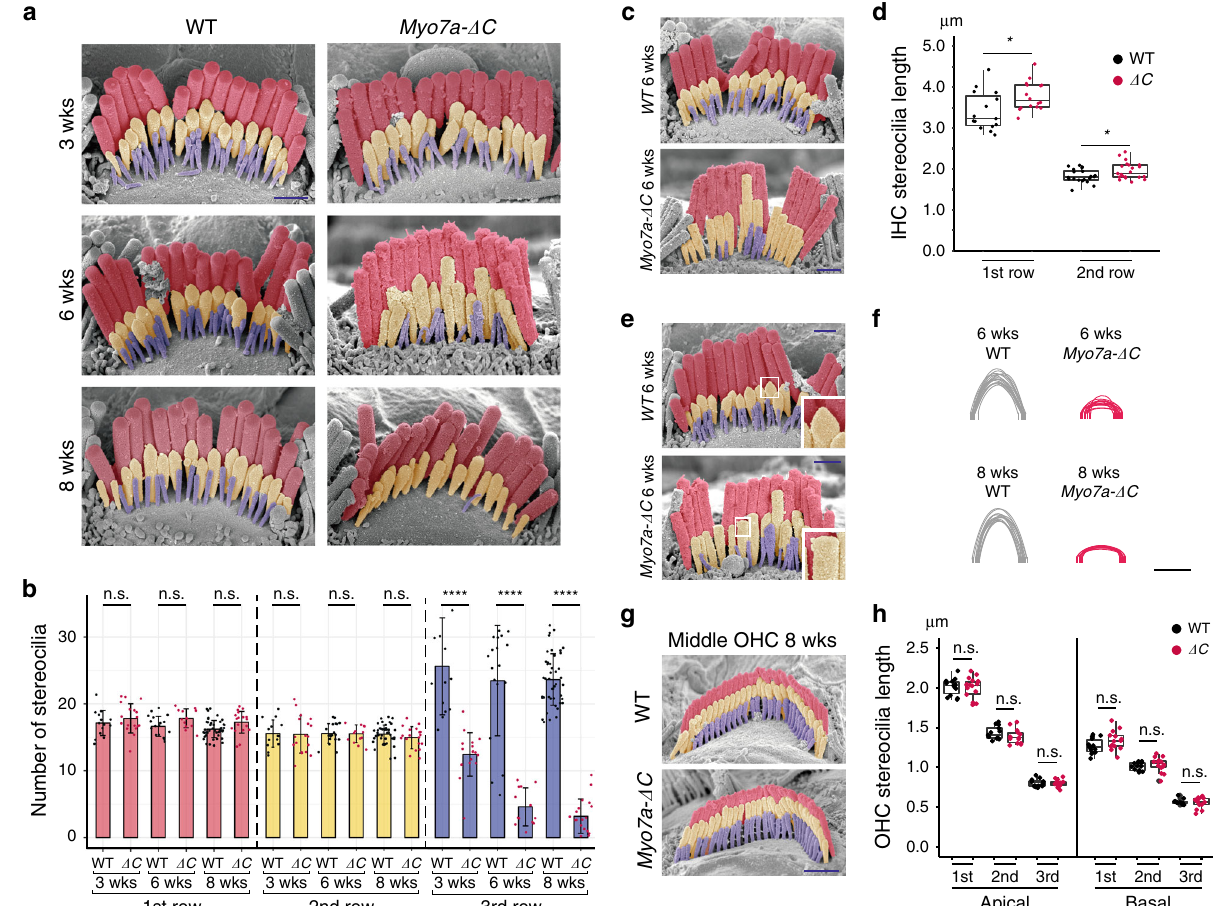
Fig. 8 IHC stereocilia degenerate in Myo7a- Δ C mice. a , b SEM analysis at 3, 6, and 8 weeks. The fi rst, second, and third row of stereocilia are shown in red, yellow, and blue, respectively. Number of third row stereocilia in Myo7a- Δ C IHCs decreases progressively: mean third row stereocilia number ± SD per cell (number of cells; animals): 3 weeks WT = 25.64 ± 7.25 (14;3), Myo7a- Δ C = 12.44 ± 3.26 (18;3), p = 7.28e − 23. 6 weeks WT = 22.65 ± 2.79 (36;6), Myo7a- Δ C = 4.50 ± 3.03 (20;5), p = 7.28e − 23. 8 weeks WT = 20.83 ± 4.54 (35;3), Myo7a- Δ C = 3.84 ± 2.54 (31;3), p = 9.41e − 26. c , d First and second row stereocilia of Myo7a- Δ C IHCs are longer than WT counterparts. SEM images are collected from the middle turn. Mean stereocilia lengths at 6 weeks (averaged by cell) ± SD. First row: WT = 3.41 ± 0.47, Myo7a- Δ C = 3.78 ± 0.35, p = 0.021; analyzed numbers (stereocilia; cells; animals) for WT (95;15;5) and Myo7a- Δ C (86;16;5). Second row: WT = 1.83 ± 0.17, Myo7a- Δ C = 1.96 ± 0.21, p = 0.033. Analyzed numbers (stereocilia; cells; animals) for WT (116;20;3) and Myo7a- Δ C (159;21;3). e , f Loss of prolate tips in second row stereocilia in Myo7a- Δ C IHC. Stereocilia tips were traced and superimposed. g , h OHC bundles at 8 weeks were not affected in Myo7a- Δ C mice. SEM-based quanti fi cation of stereocilia lengths: basal OHCs: First row: WT = 1.27 ± 0.094, Myo7a- Δ C = 1.34 ± 0.12, p = 0.089. Second row: WT = 1.01 ± 0.050, Myo7a- Δ C = 1.032 ± 0.096, p = 0.52. Third row: WT = 0.57 ± 0.031, Myo7a- Δ C = 0.55 ± 0.069, p = 0.58. Analyzed numbers (stereocilia; cells; animals) for WT (188;14;5) and for Myo7a- Δ C (153;12;4). Apical OHCs: First row: WT = 2.01 ± 0.10, Myo7a- Δ C = 1.99 ± 0.13, p = 0.688. Analyzed numbers (stereocilia; cells; animals) for WT (131;13;3) and for Myo7a- Δ C (137;18;4). Second row: WT = 1.43 ± 0.082, Myo7a- Δ C = 1.39 ± 0.082, p = 0.21. Analyzed numbers (stereocilia; cells; animals) for WT (99;13;4) and for Myo7a- Δ C (94;14;3). Third row: WT = 0.80 ± 0.049, Myo7a- Δ C = 0.80 ± 0.045, p = 0.95. Analyzed numbers (stereocilia; cells; animals) for WT (99;13;4) and for Myo7a- Δ C (94;14;3). Boxplots show medians, 25th and 75th percentiles as box limits, and minima and maxima as whiskers. p values in b , d , and h were derived from two-tailed, unpaired t -tests (error bars indicate SD and n = number of cells). All scale bars: 1 μ m (except in e and f : 0.2 μ m). Source data are provided in the Source Data fi